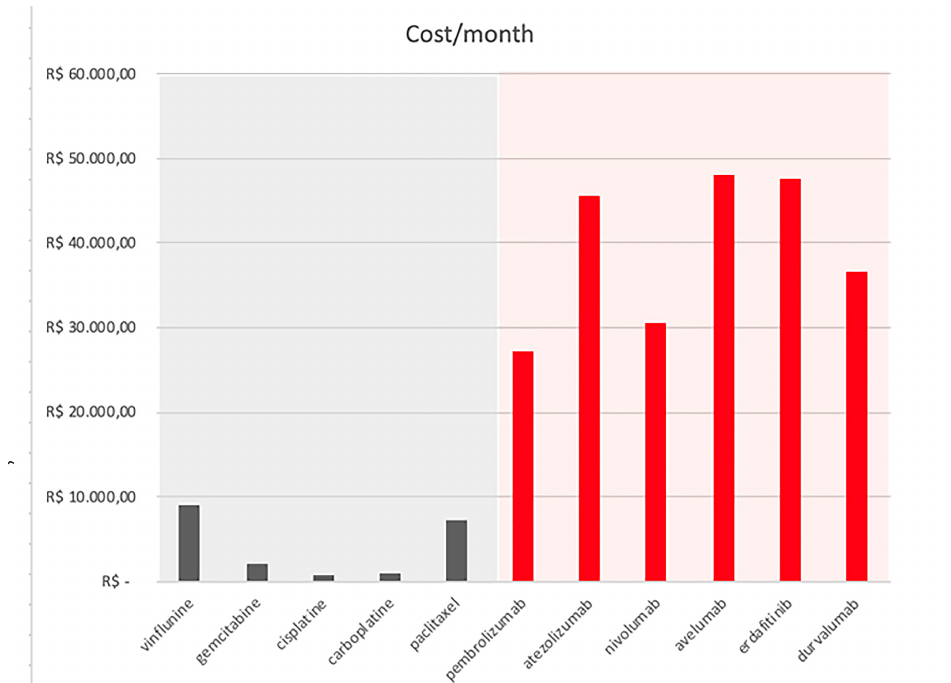
Figure 1 - FDA (USA Food and Drug Administration) approved medications to treat BC currently available in Brazil and their estimated costs in R$ in 2020. In gray medications available before 2016. In red, medications available since 2016.